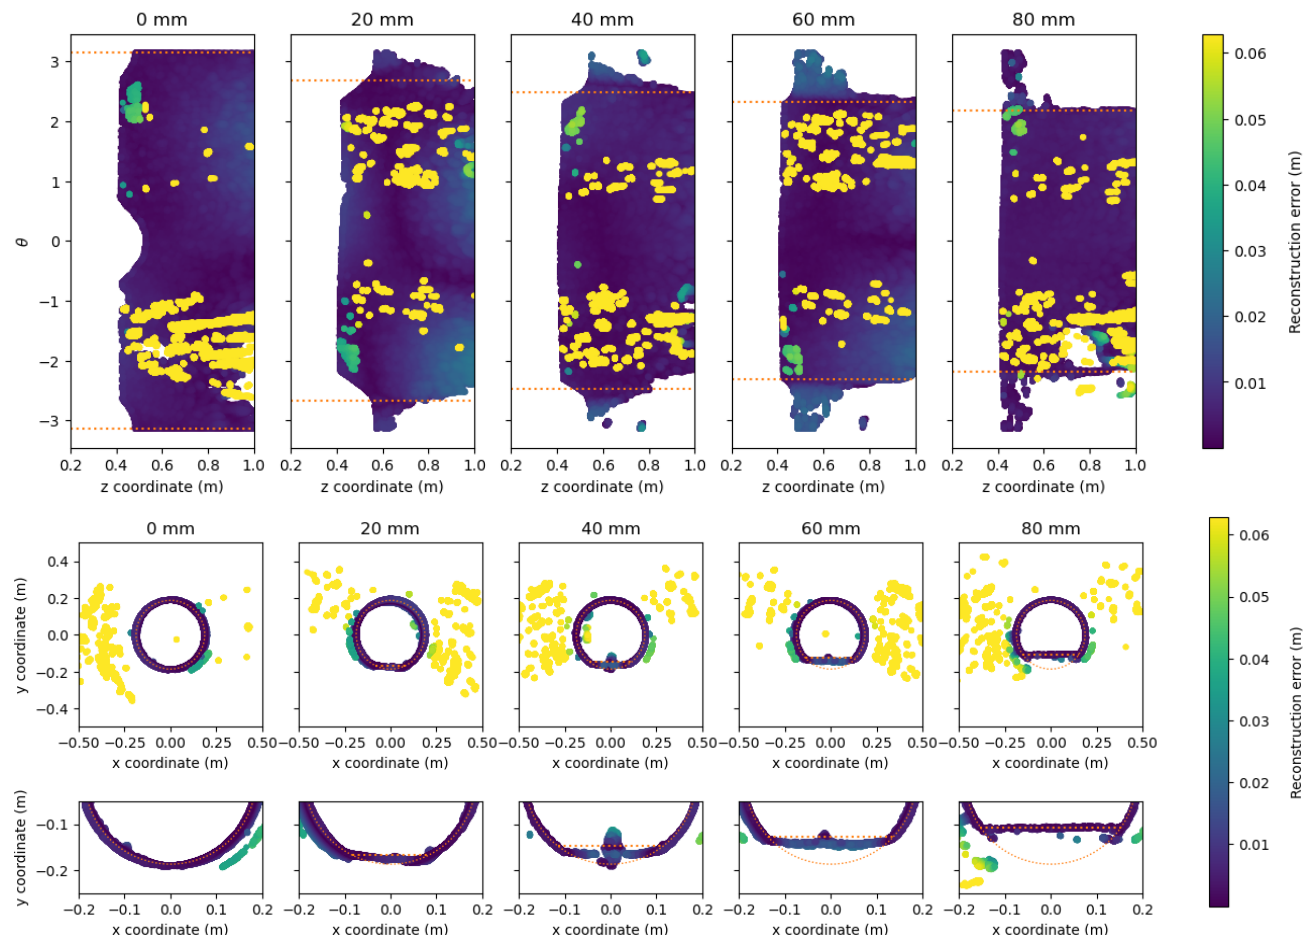
Figure 16. Reconstructed point cloud for the water level experiments by the Realsense-On camera. The water level and pipe geometry is indicated with the orange line. The points are color-coded according to the cloud-to-mesh distance to the reference pipe. ( Top ) unfolded view of the reconstructed pipe. The water level is indicated with an orange dotted line. ( Middle ) View from the XY-plane of the reconstructed pipe. ( Bottom ) Zoomed in view of the XY-plane of the reconstructed